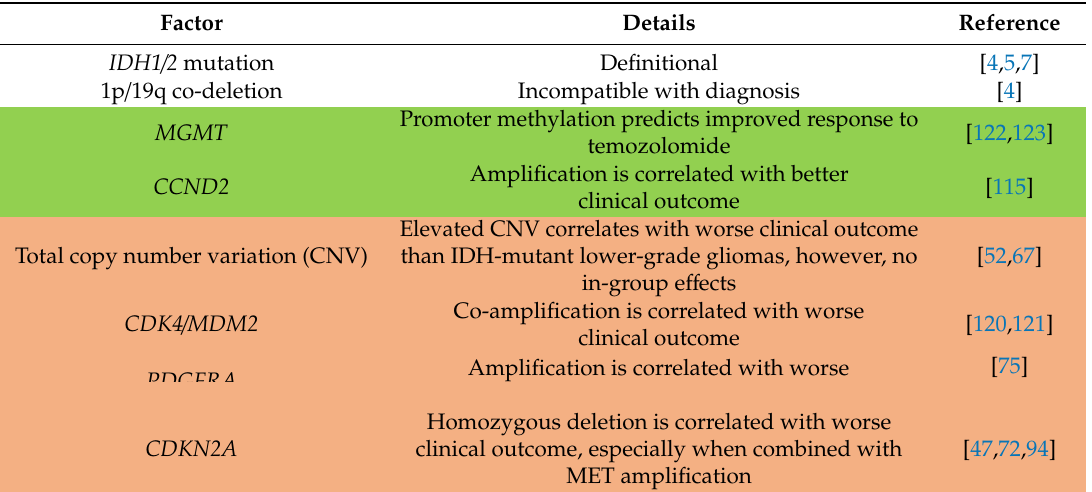
Table 3. Prognostic factors in IDH-mutant